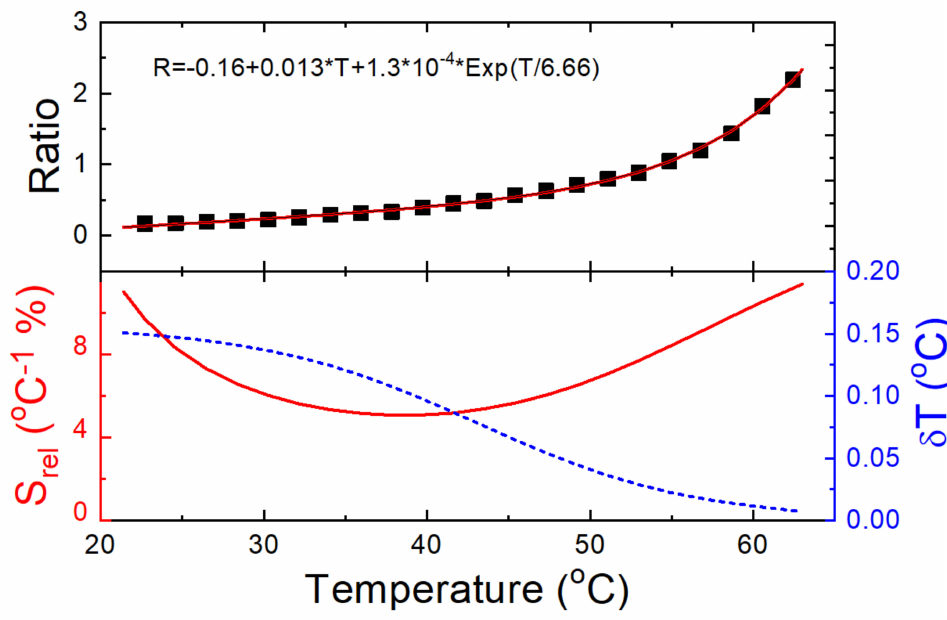
Figure 6. Ratio measurements as a function of temperature (top), relative sensitivity (bottom— continuous red line) and temperature uncertainty (bottom—dashed blue